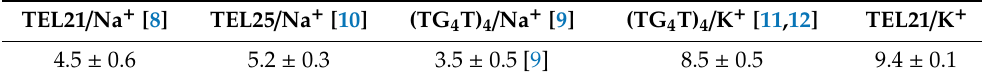
Table 1. Quantum yields ( φ 1 × 10 3 ) determined at 266 nm for one-photon ionization of G - quadruplexes.